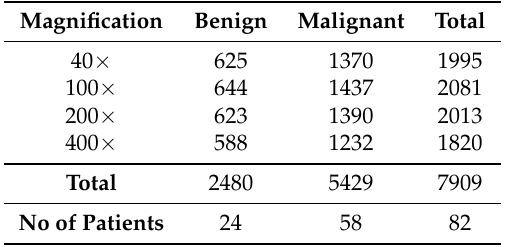
Table 9. Image distribution of BreaKHis dataset by magnification factor and class.